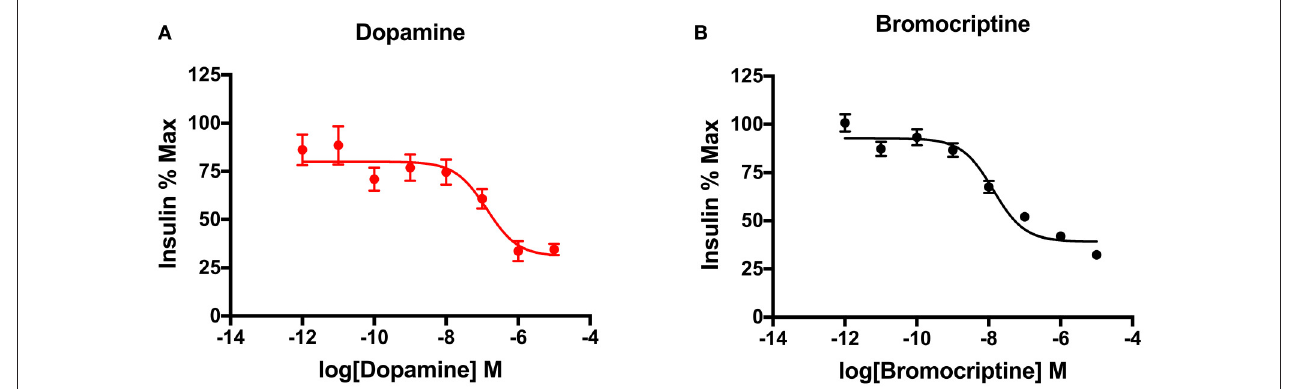
FIGURE 2 | Dopaminergic modulation of insulin secretion in pancreatic beta cells. (A) Treatment of INS-IE cells, an established rat pancreatic beta cell-derived cell line, with dopamine potently inhibited glucose-stimulated insulin secretion in a dose-dependent manner (pIC 50 = 7.83). (B) Agonism of dopamine D 2 and D 3 receptors by bromocriptine produced a decrease in glucose-stimulated insulin secretion comparable to dopamine (pIC 50 = 6.87), suggesting that these receptors are important in mediating this effect in beta cells. Insulin secretion was measured via homogenous time-resolved fluorescence (HTRF) as described earlier (Farino et al., 2016 ). All experiments were performed in triplicate on n ≥ 3 separate experimental days. Data are represented as % maximal insulin secretion based on mean HTRF values ±